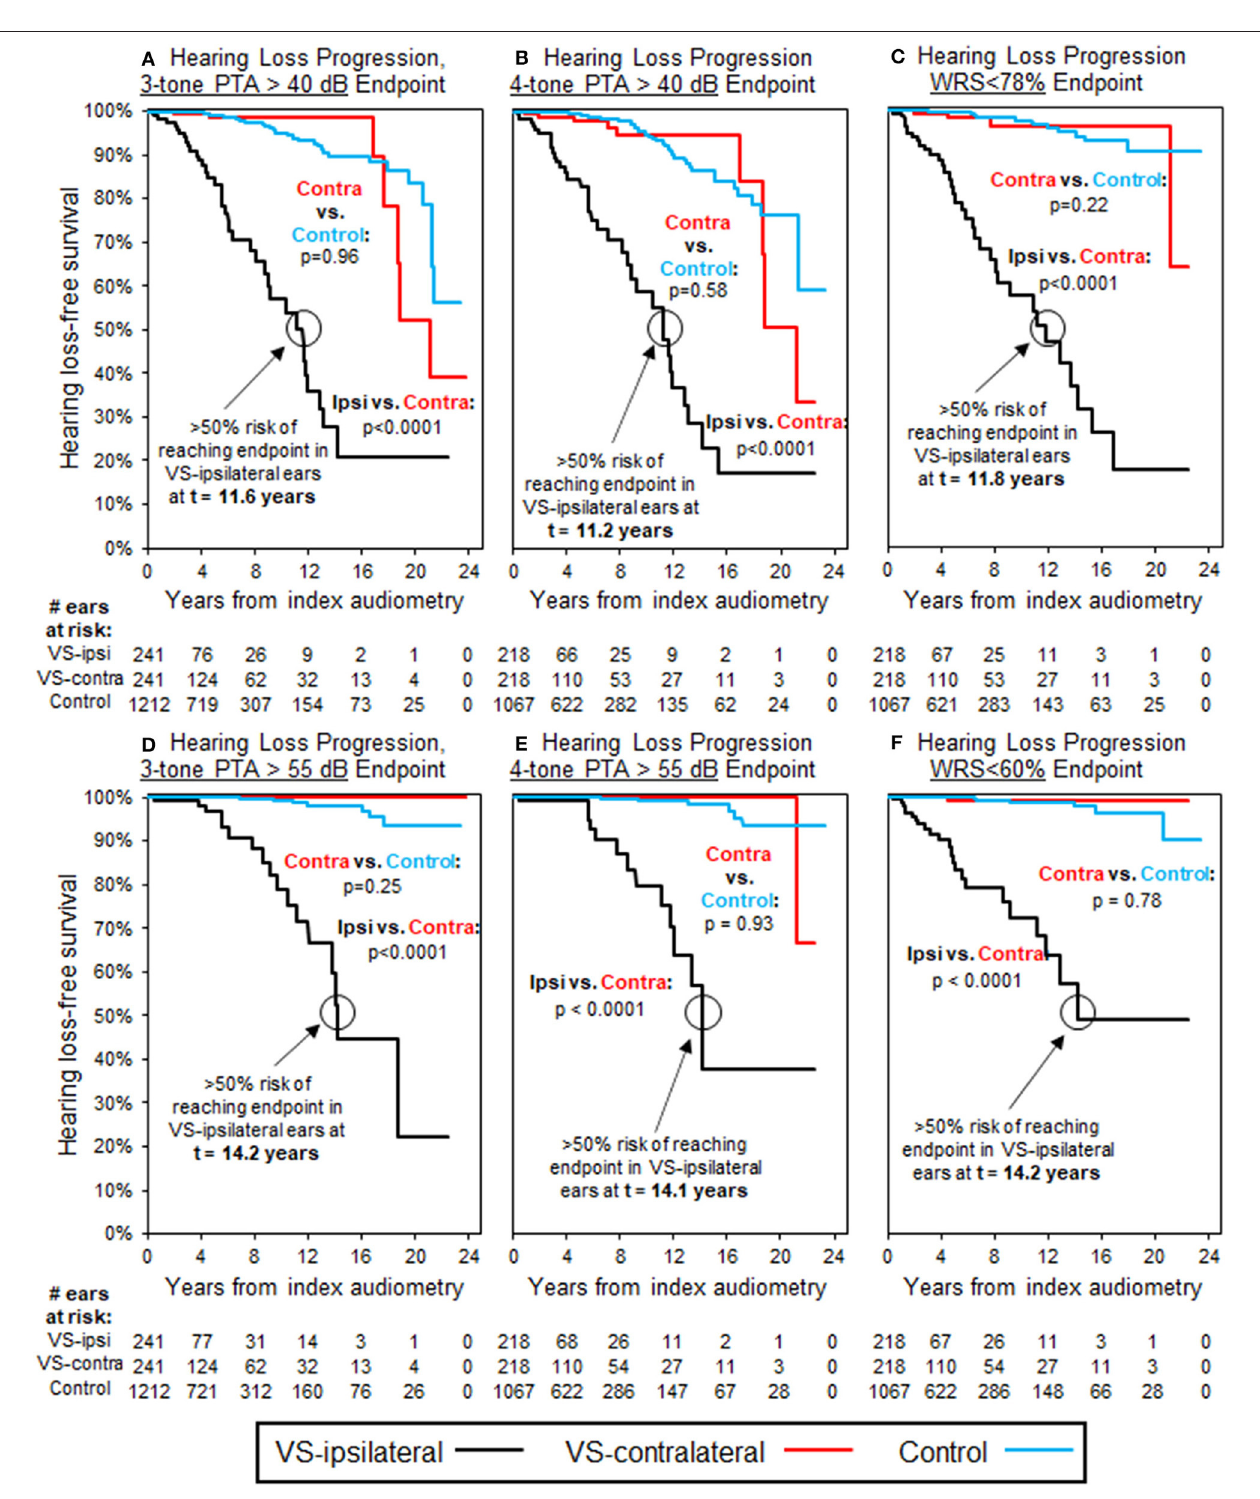
FIGURE 2 | Kaplan-Meier curves for HL progression in patients with baseline normal hearing bilaterally (WRS ≥ 92% and PTA ≤ 25 dB bilaterally); see Table 3 for demographics. Analysis uses three-tone PTA to assess baseline hearing in (A,D) , as well as endpoint in (A) , while four-tone PTA used, respectively in (B,C,E,F) . Endpoint bone three-tone PTA > 40 dB (moderate HL); (B) Endpoint bone four-tone PTA > 40 dB (moderate HL); (C) Endpoint word understanding < 78%; (D) Endpoint bone three-tone PTA > 55 dB (moderately severe HL); (E) Endpoint bone four-tone PTA > 55 dB (moderately severe HL); (F) Endpoint word understanding < 60%. All control ears with normal baseline hearing defined by same criteria as for VS-ipsilateral and contralateral ears.